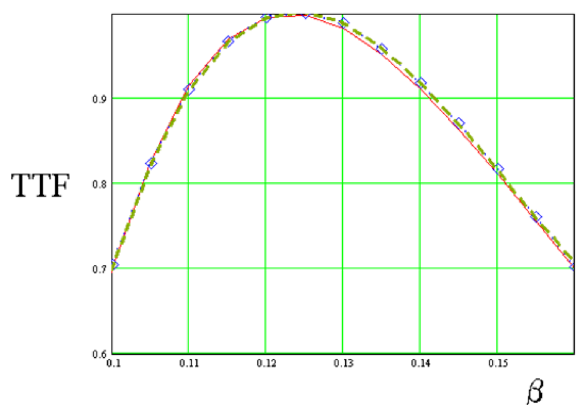
FIG. 8. (Color) TTF curve of the ladder resonator (blue dia- monds), plotted together with the polynomial approximation [Eq. (1), green dashed curve] and the 4-thin-gap approximation [Eq. (2), red solid